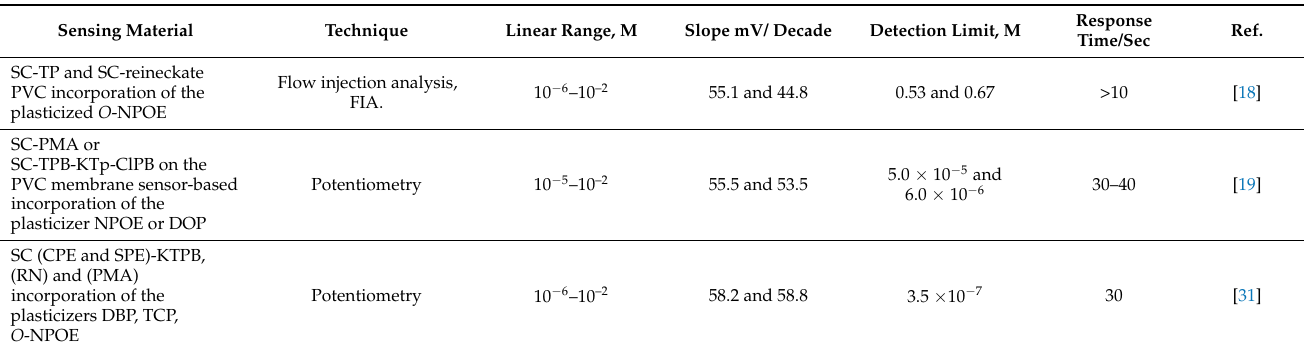
Table 6. The comparison between the previous methods and the proposed method regarding the determination of vitamin V using electrochemical